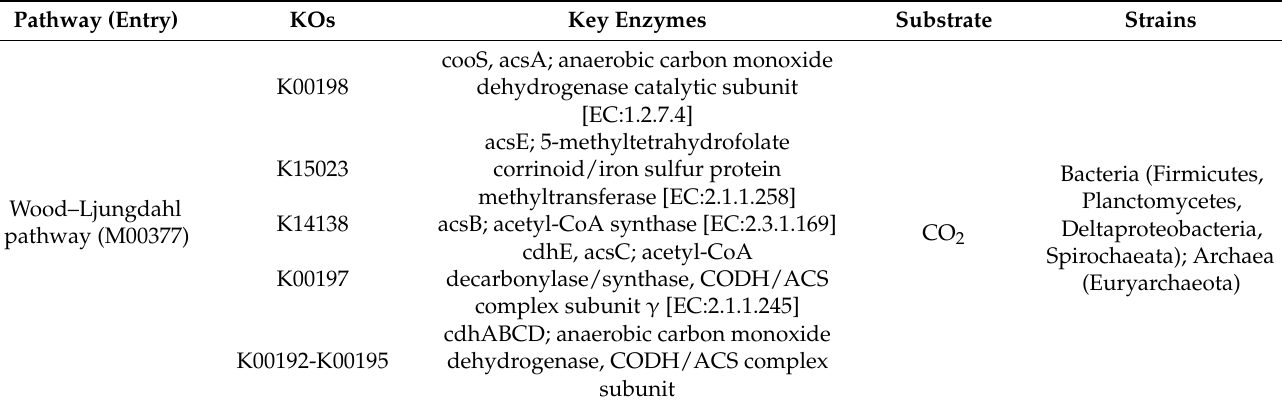
Table 2. Wood–Ljungdahl pathway of the Bacteria and Archaea.